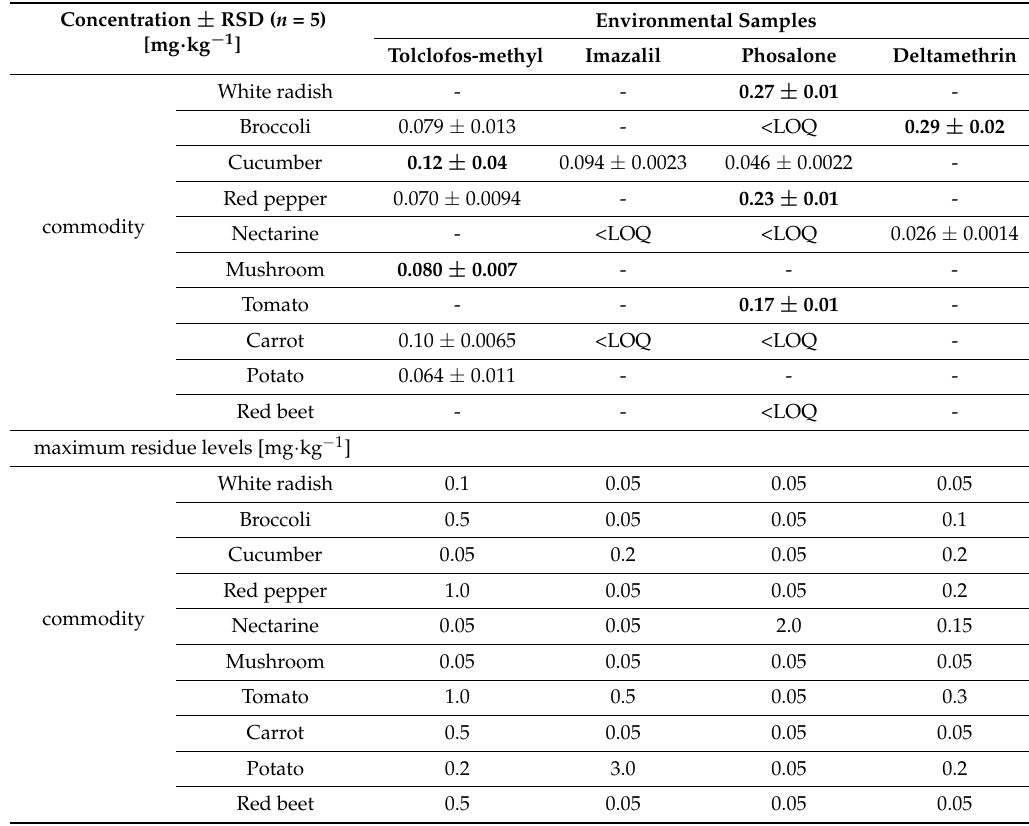
Table 3. Mean values of pesticide concentrations with uncertainty determined in environmental samples and MRLs